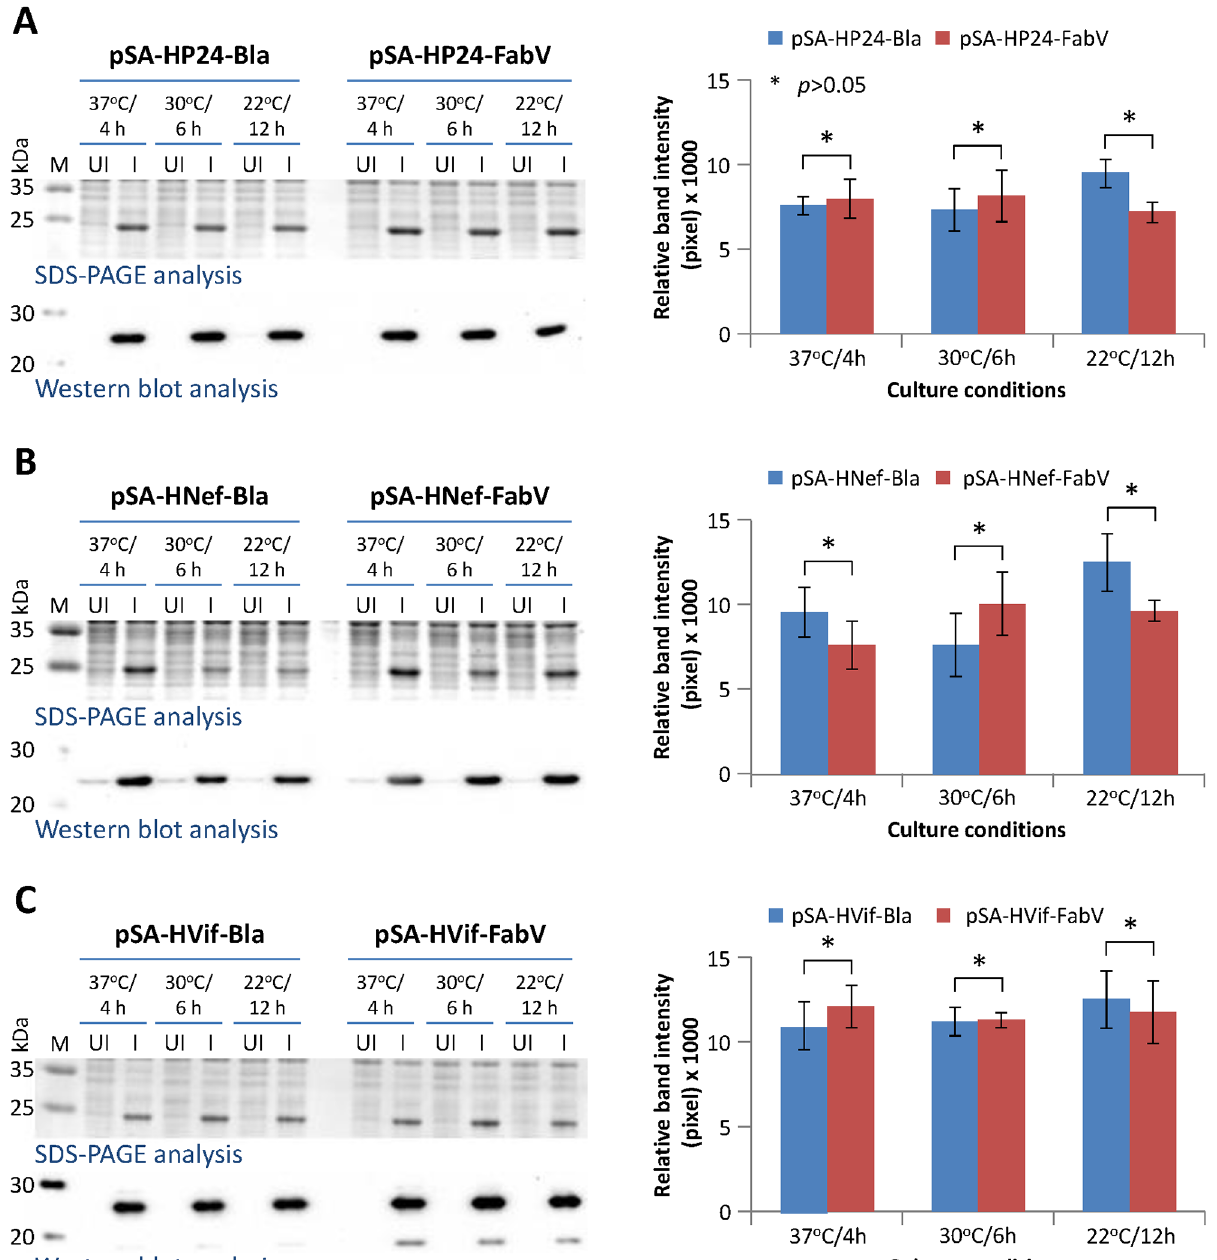
Fig 6. Effect of plasmid retention/stability on protein expression. BL21(DE3) cells were transformed with Bla or FabV vectors and uninduced and IPTG -induced cultures were grown at 37°C/4h, 30°C/6h, and 22°C/12 h in presence of Ampicillin (for bacteria containing Bla vectors) or Triclosan (for bacteria containing FabV vectors). (A) Cultures expressing P24 protein; (B) cultures expressing Nef protein; (C) cultures expressing Vif protein. Left panel shows SDS-PAGE/western blots and right panel shows densitometric analyses of bands on western blots. Error bars show standard deviations calculated from three independent experiments each performed in